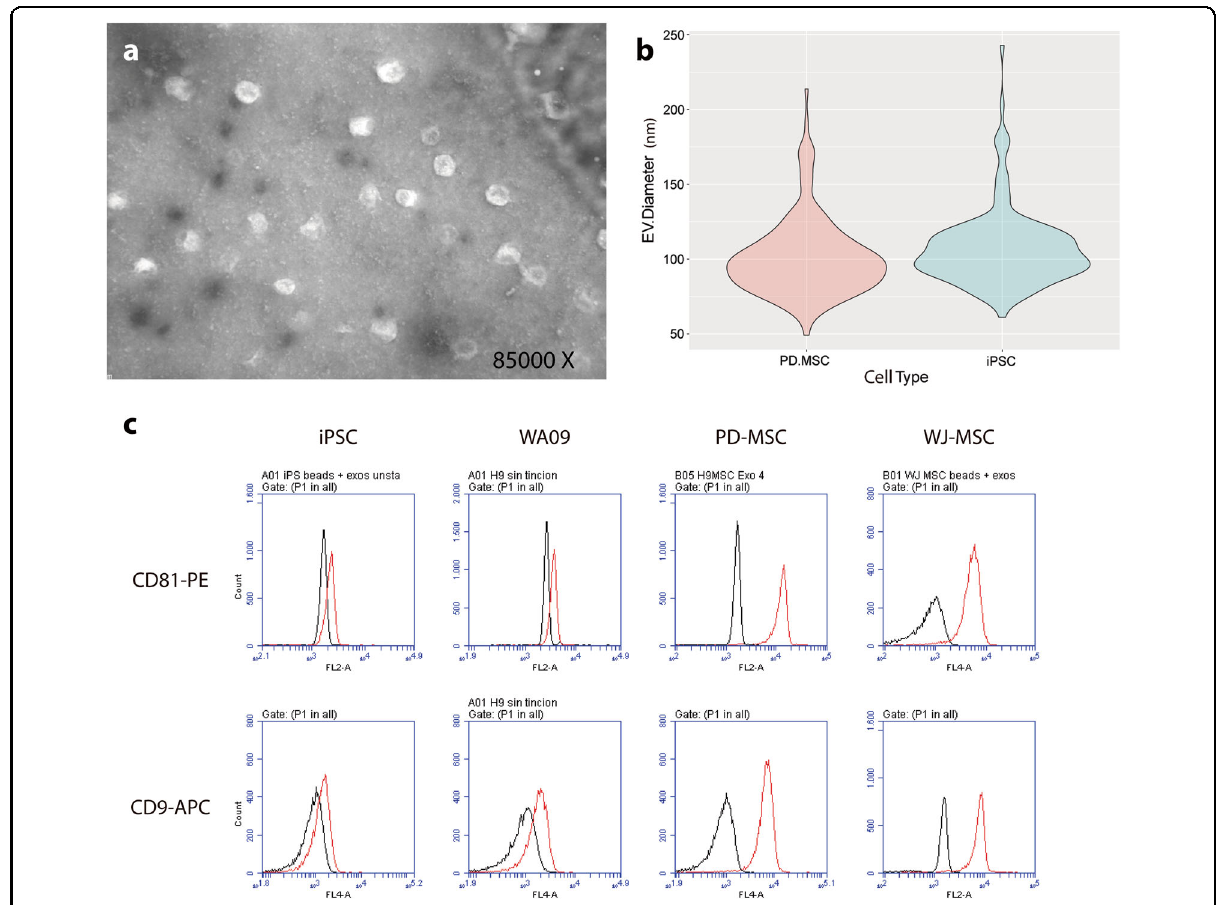
Fig. 1 Characterization of EVs isolated from cell lines. a Transmission electron microscopy (TEM) of PD-MSC. b Quanti fi cation of diameters of PD- MSC EVs (left violin plot) and iPSC EVs (right violin plot) using ImageJ. c Flow cytometry analysis of EVs from different cell lines. After isolation, EVs were bound to anti-CD63-coated magnetic beads and were stained either with a CD81-PE-conjugated or a CD9-APC-conjugated